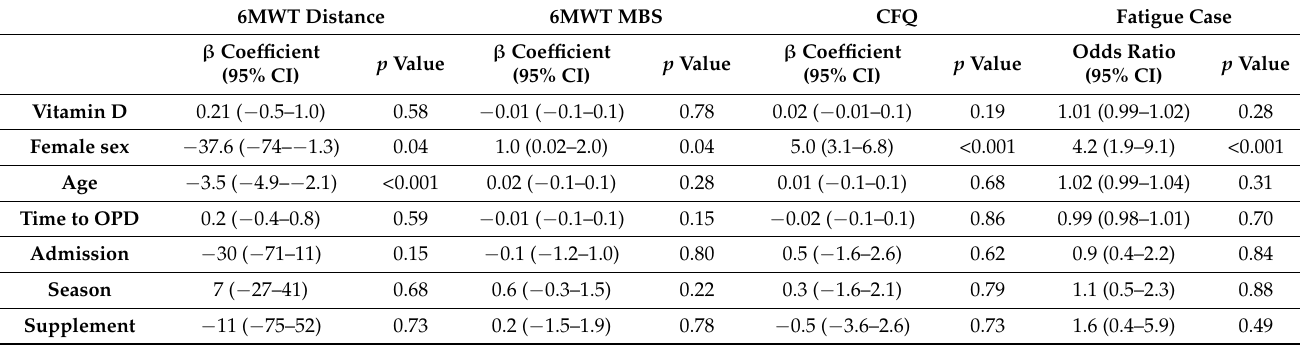
Table 2. Multivariable regression analysis of relationship between vitamin D levels and physical health post-COVID-19.